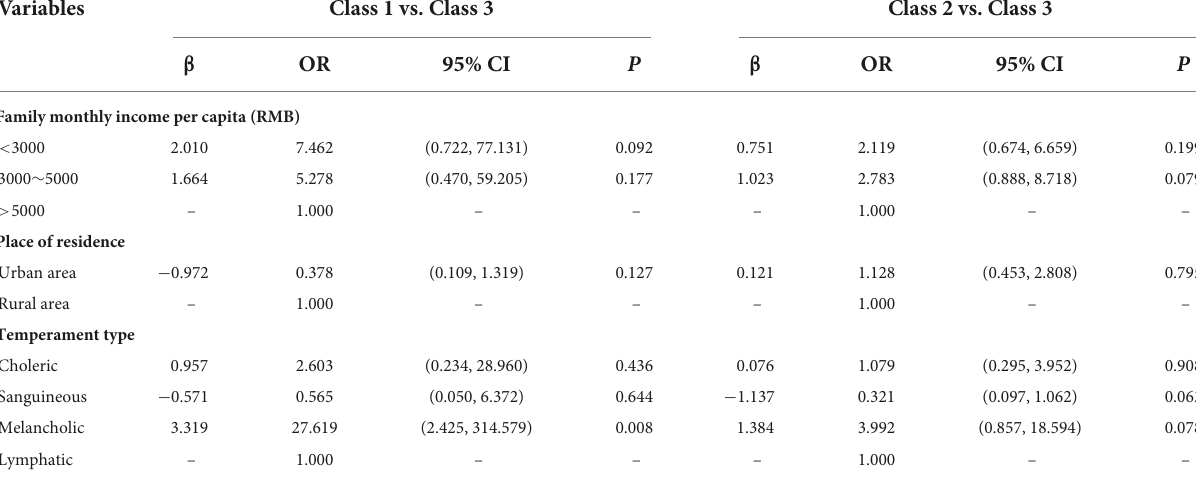
TABLE 3 Logistic regression analysis of social avoidance trajectory categories in patients with breast cancer ( n =